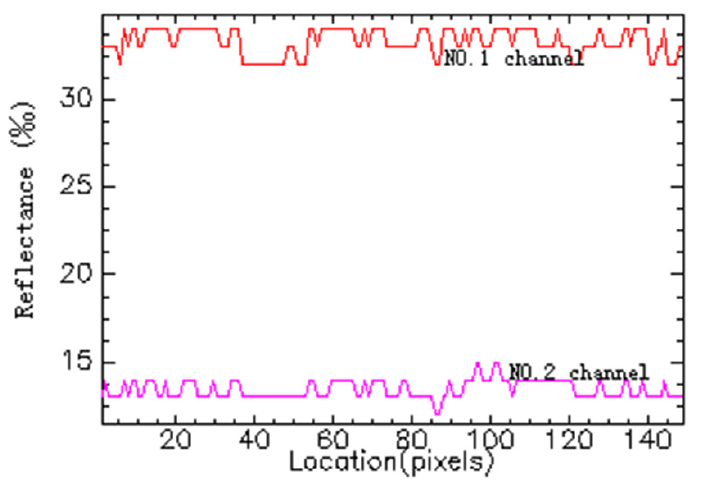
Figure 11. The water reflectance of channel 1 and channel 2 on the cutting line of an AVHRR/2 image (the location is indicated with the pixel numbers on the line).